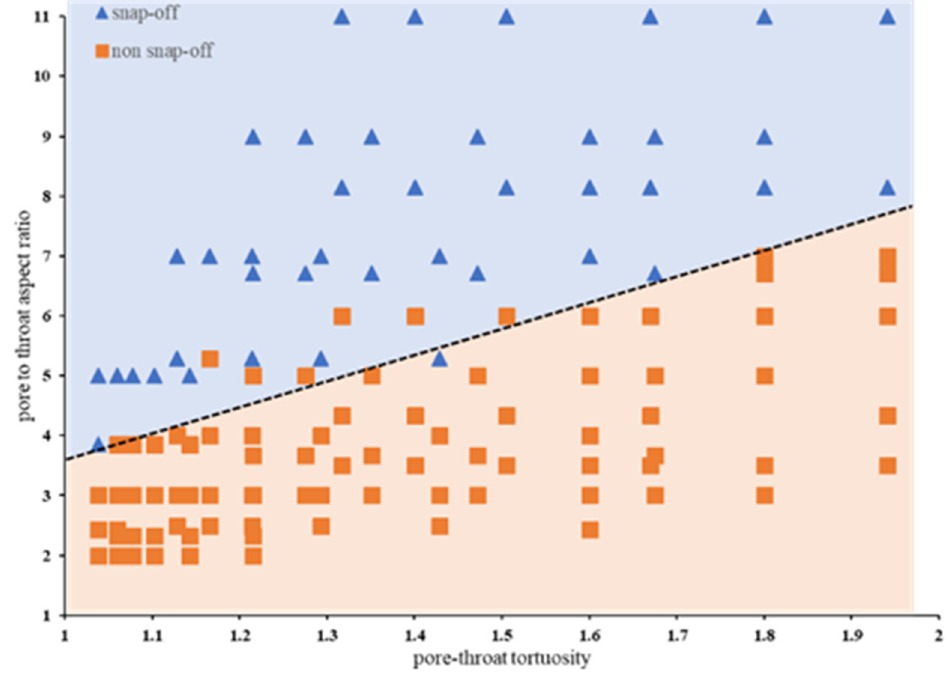
Figure 14. Distribution of snap-off and non-snap-off phenomena during the spontaneous imbibition process.